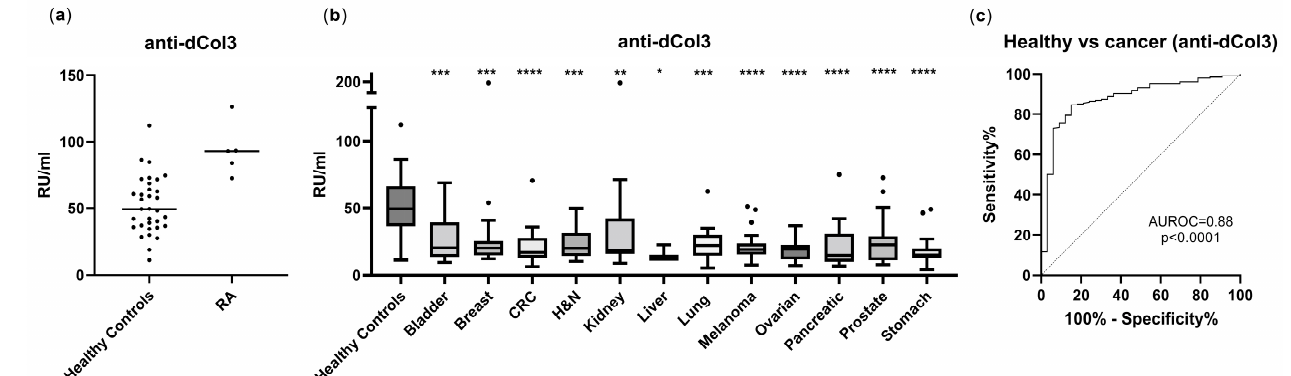
Figure 1. Anti-dCol3 levels were significantly decreased in 12 types of cancer compared to healthy controls. ( a ) Anti-dCol3 levels in rheumatoid arthritis (RA) patients (n = 5) compared to healthy controls (n = 33). The line represents the median. ( b ) Anti-dCol3 levels in patients with bladder cancer (n = 20), breast cancer (n = 20), colorectal cancer (n = 20), head and neck cancer (n = 20), kidney cancer (n = 20), liver cancer (n = 3), lung cancer (n = 20), melanoma (n = 20), ovarian cancer (n = 20), pancreatic cancer (n = 20), prostate cancer (n = 20), and stomach cancer (n = 20) compared to healthy controls (n = 33). Biomarker levels are presented as Tukey box plots, and statistical differences were analyzed using the Kruskal–Wallis test adjusted for Dunn’s multiple comparisons tests. * p < 0.05, ** p < 0.01, *** p < 0.001, **** p < 0.0001. ( c ) ROC analysis for identi fi cation of diagnostic power of anti-